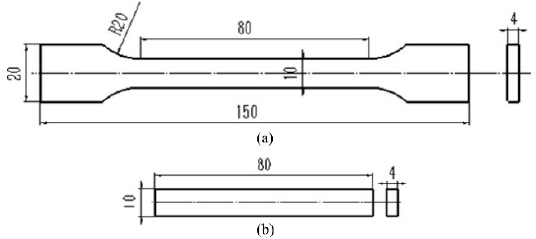
Figure 17. Test sample size: ( a ) Tensile sample, ( b ) Three-point bending sample.